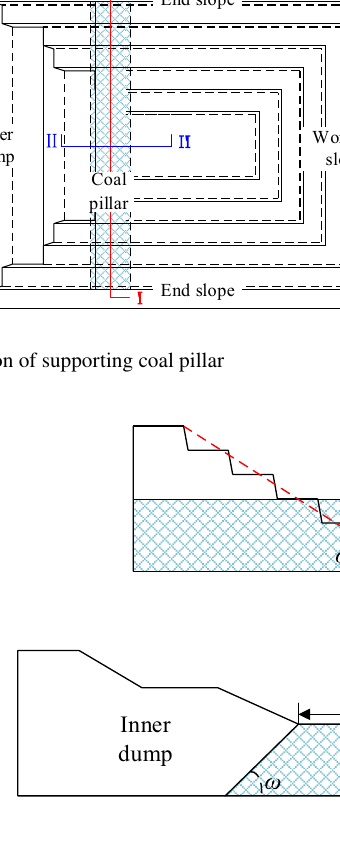
Fig. 2 Section shape of supporting coal